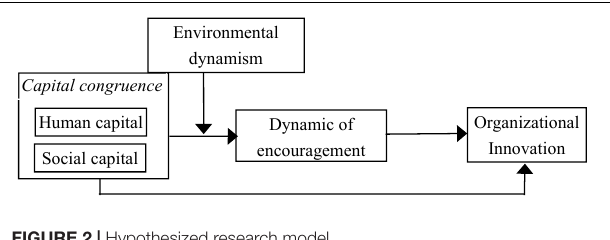
FIGURE 2 | Hypothesized research